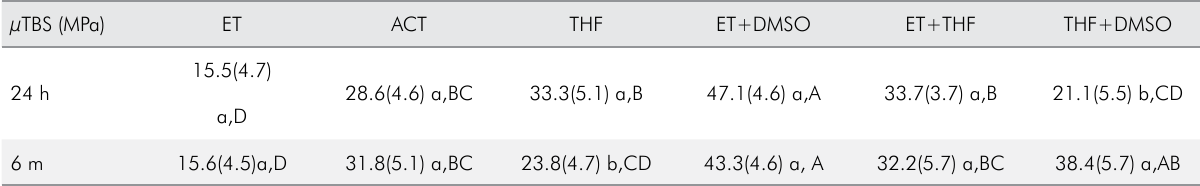
Table 2. Means (standard deviation) of microtensile bond strength